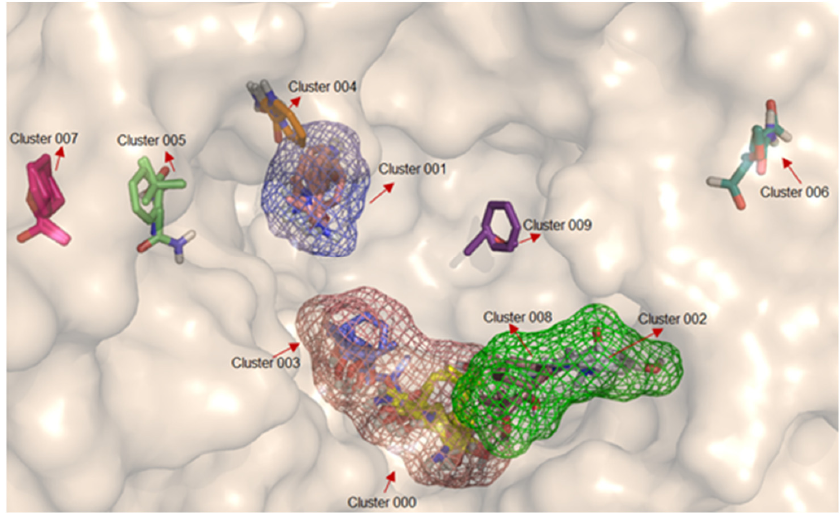
Figure 4. Clusters containing the molecule probes anchored in the A-chain of DPP-4 (PDB 4A5S). Site 1 in salmon, site 2 in green and site 3 in blue.